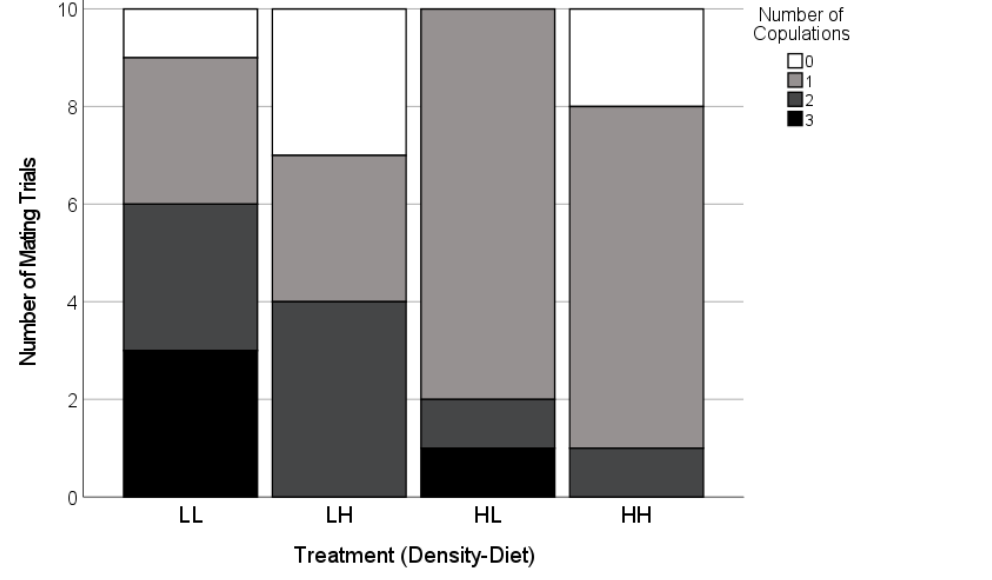
Figure 2. Copulation frequency of adult females paired with novel males as a function of the experimental conditions during their final two juvenile instars. The experiment crossed two male densities (H = high; L = low) with two diet levels (H = high; L = low). Very few females did not mate (white). For the trials where mating occurred, the females exposed to a low density of males (LL, LH) often copulated two or three times (dark grey and black) whereas the females exposed to a high density of males (HL, HH) more frequently copulated only once (light grey, Table 1).